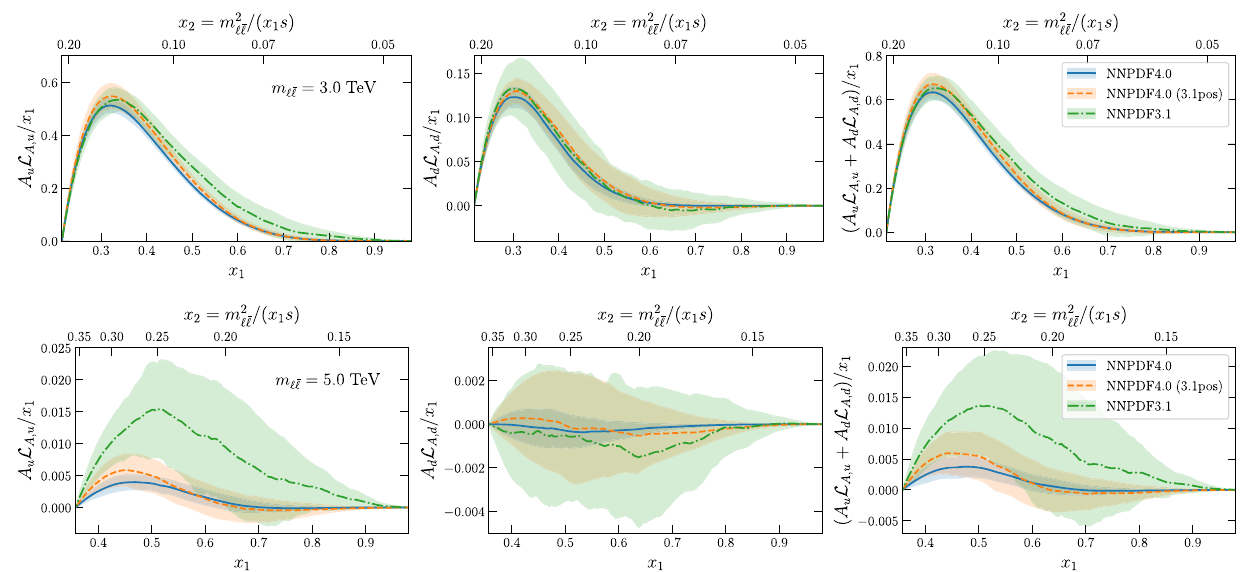
Fig. 23 Same as Fig. 13 for the antisymmetric partonic luminosities L A , q , comparing NNPDF4.0, NNPDF4.0(3.1pos), and NNPDF3.1.